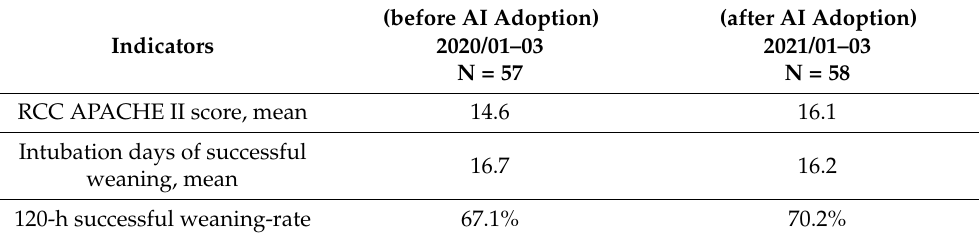
Table 5. The Preliminary Results of Clinical Evaluation and Comparison. (before AI Indicators